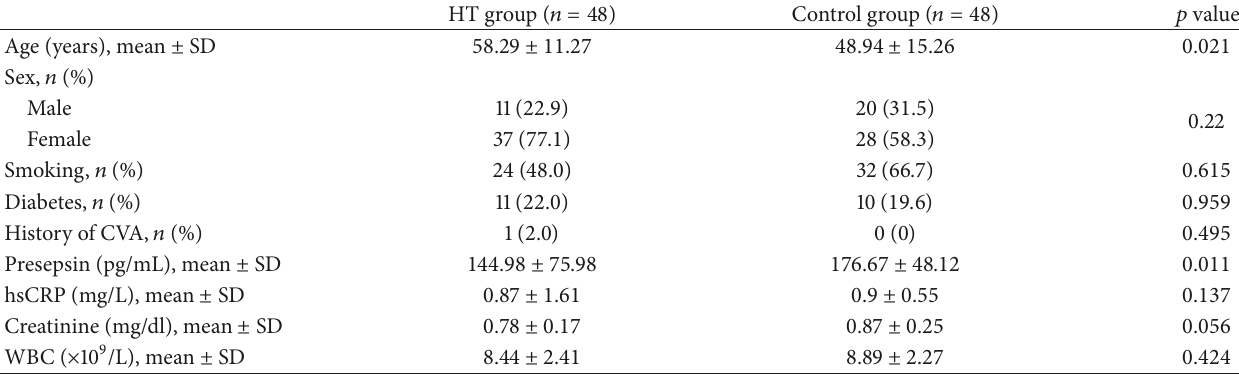
Table 1: Demographic features and laboratory findings of HT and control